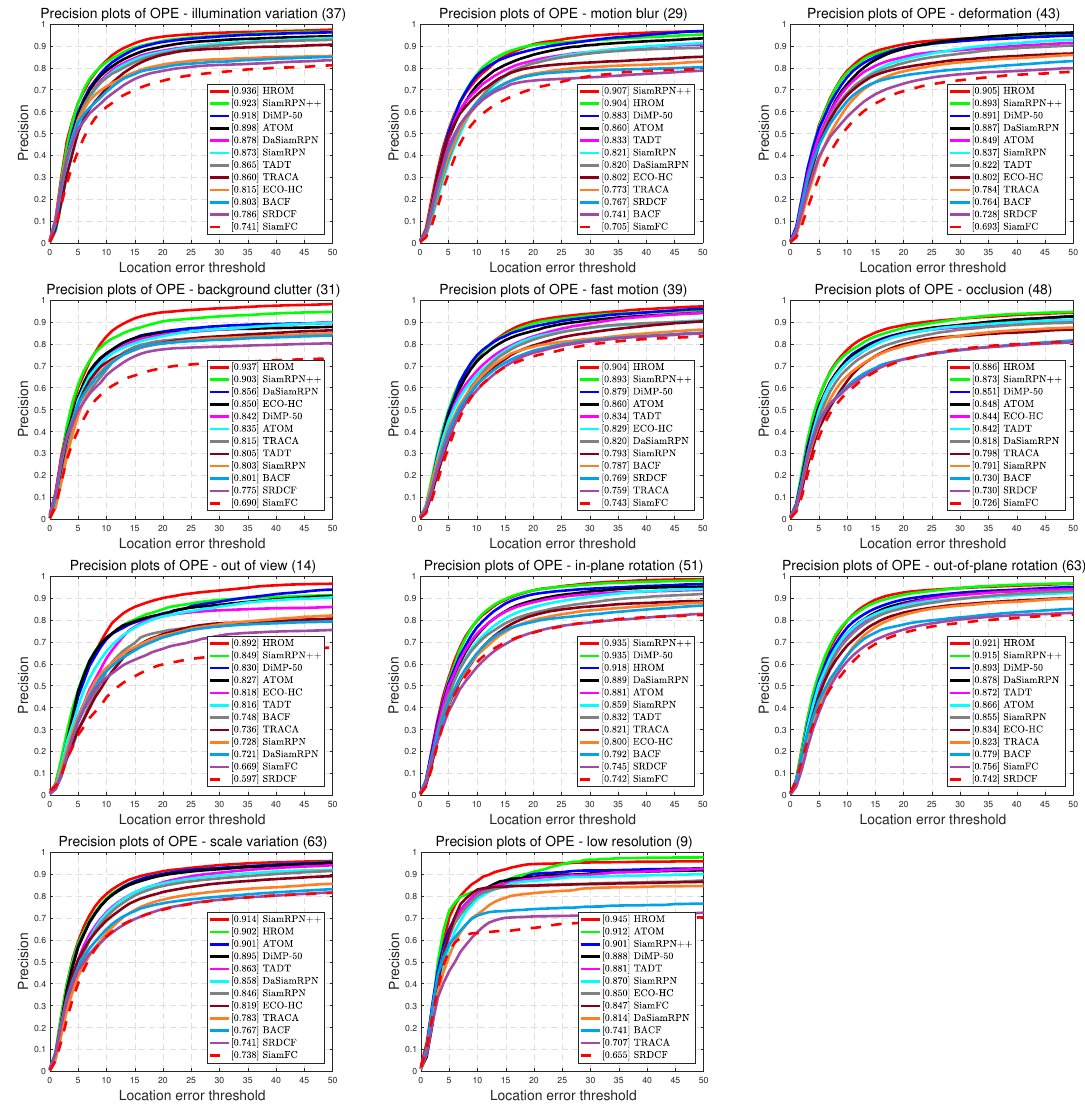
Figure 8. Precision plots of different trackers with 11 attributes on the OTB-2015